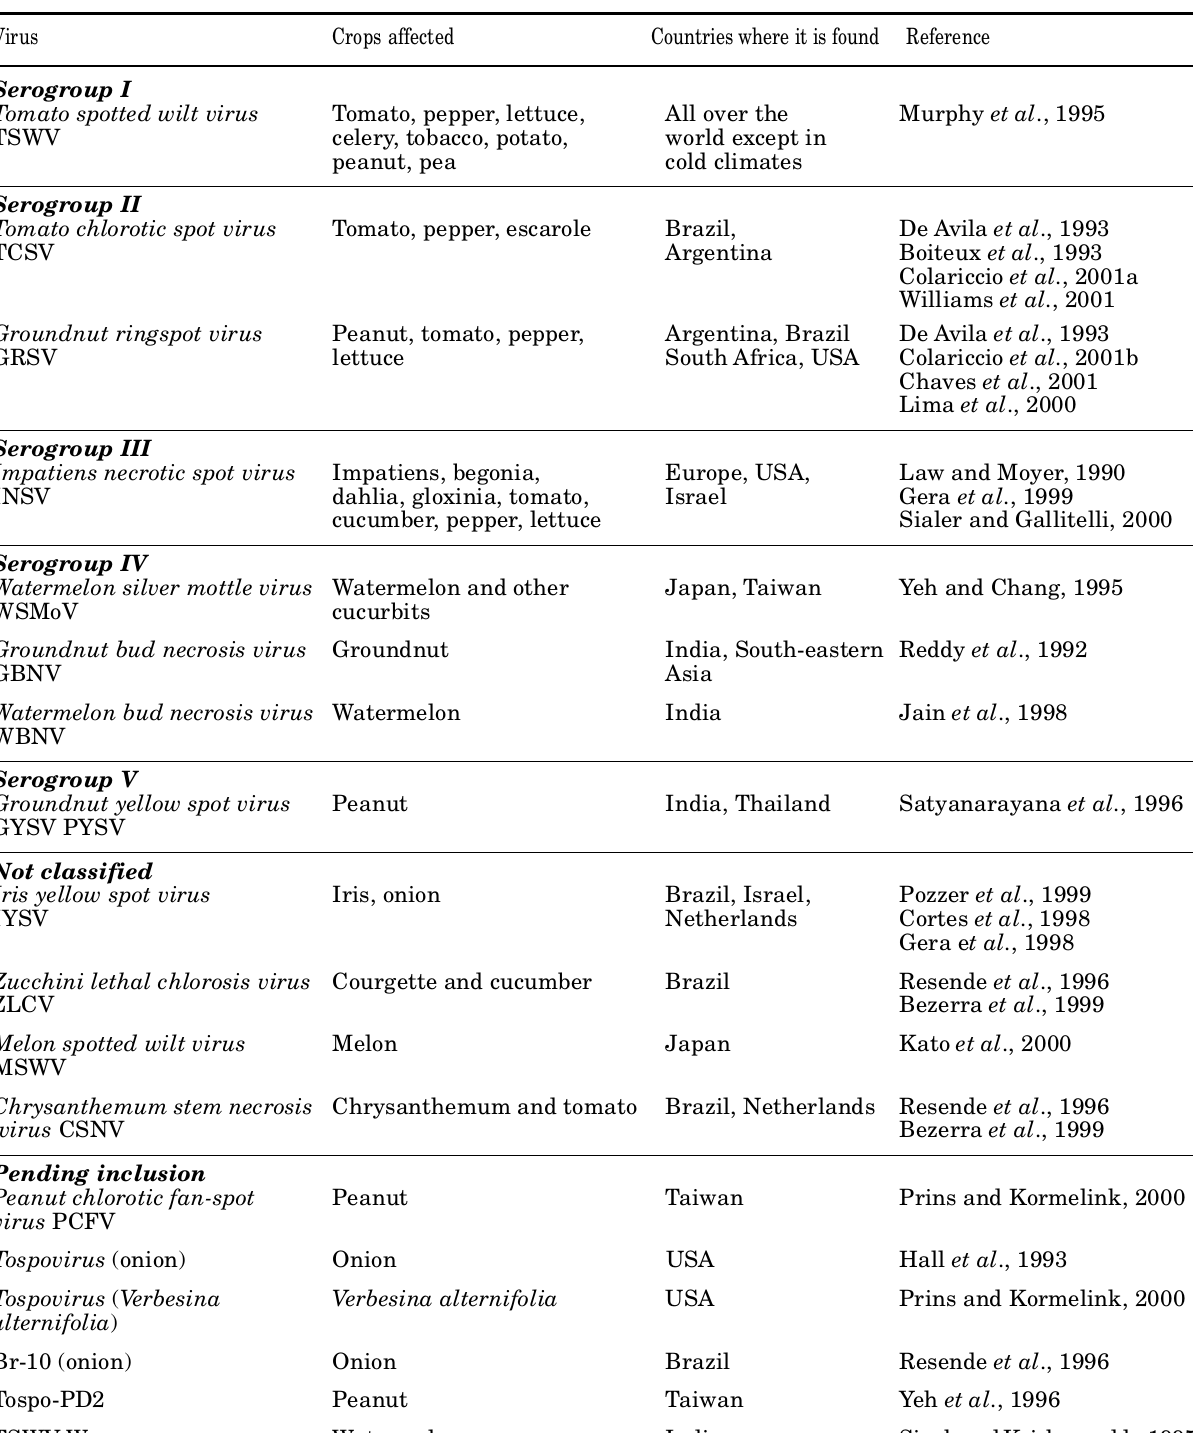
Table 1. Classification of the genus Tospovirus in